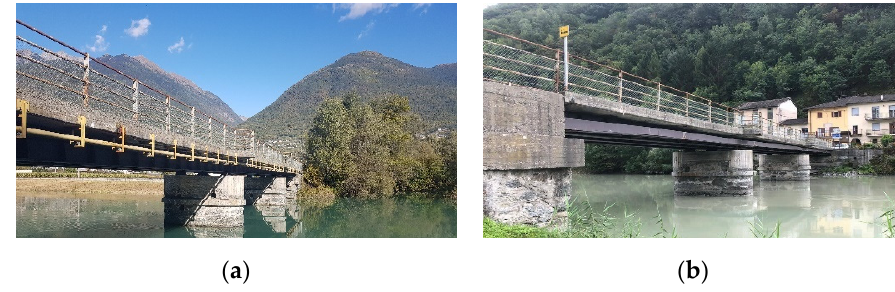
Figure 1. The Baghetto Bridge: view from ( a ) upstream and ( b ) downstream.